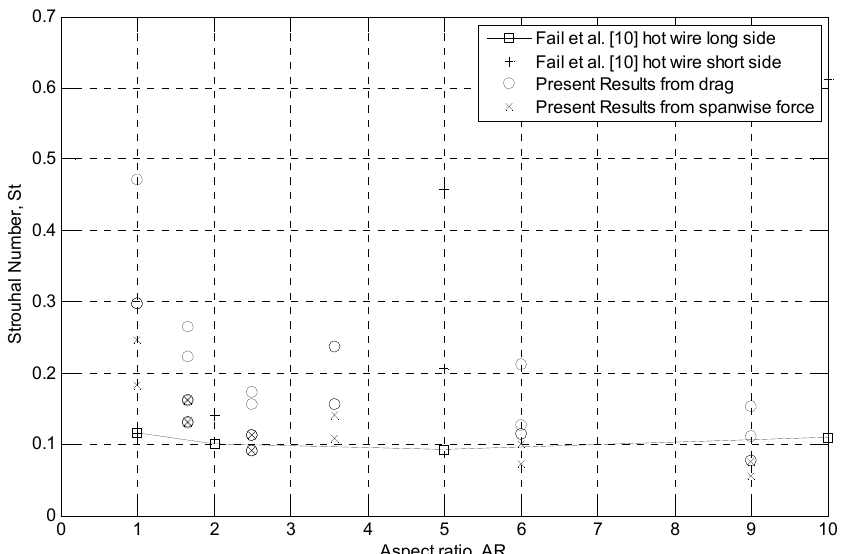
Figure 14. Strouhal numbers for the spectral peaks such as those in Figure 13 for the drag and spanwise force compared to the hot-wire spectral peaks from Fail et al.